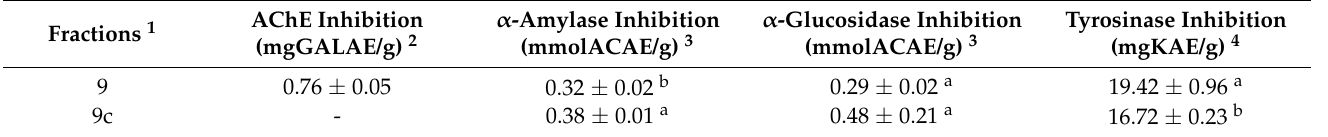
Table 6. Summary of enzymatic activity.